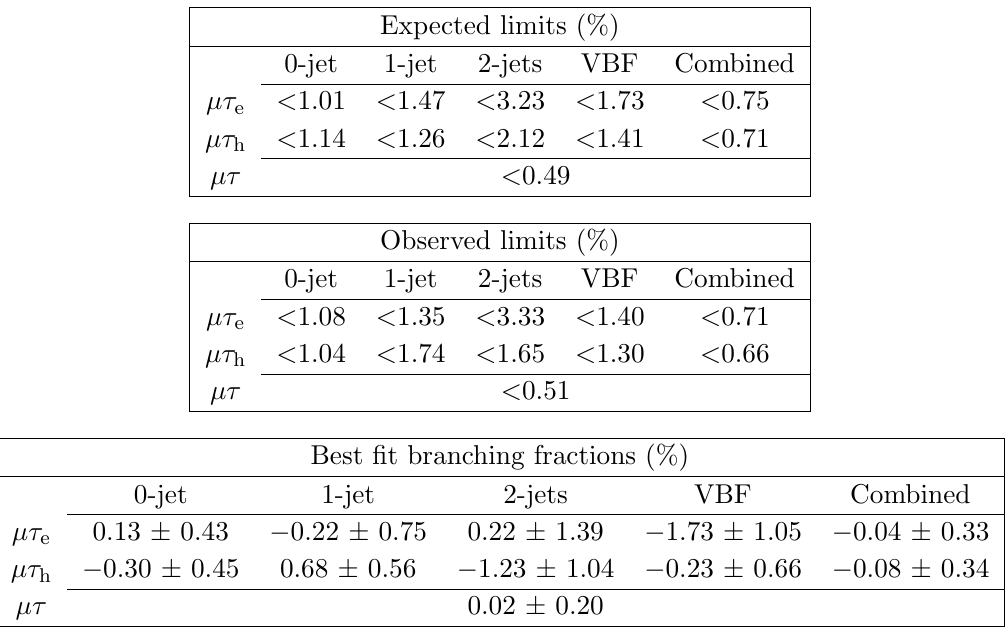
Table 5 . Expected and observed upper limits at 95% CL, and best (cid:12)t branching fractions in percent for each individual jet category, and combined, in the H ! (cid:22)(cid:28) process obtained with the M col (cid:12)t analysis.